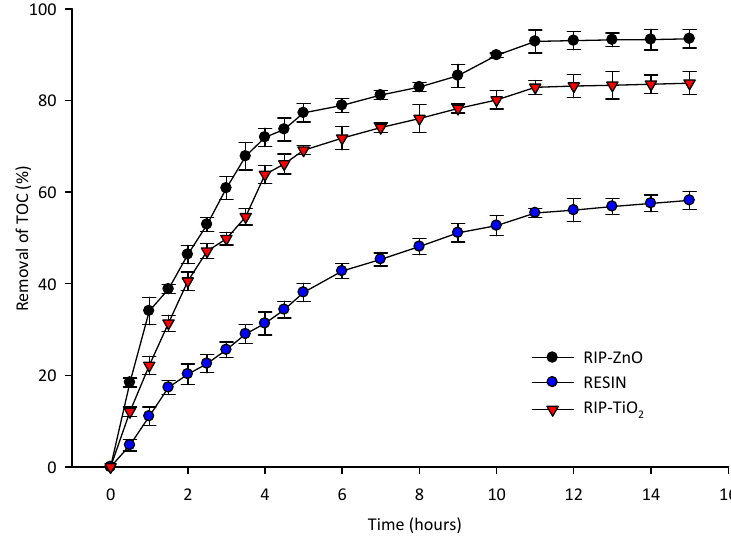
Fig. 1: Performance of resin, RIP‐TiO 2 , and RIP‐ZnO in removing TOC and (b) UV 254 in tofu wastewater.